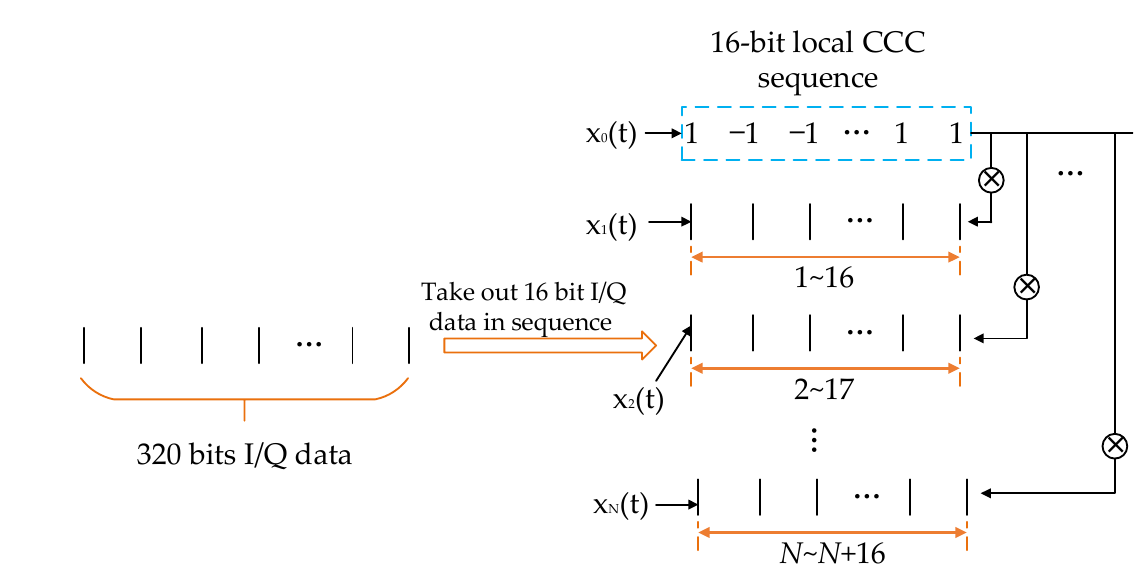
Figure 7. Range difference model based on received signal.